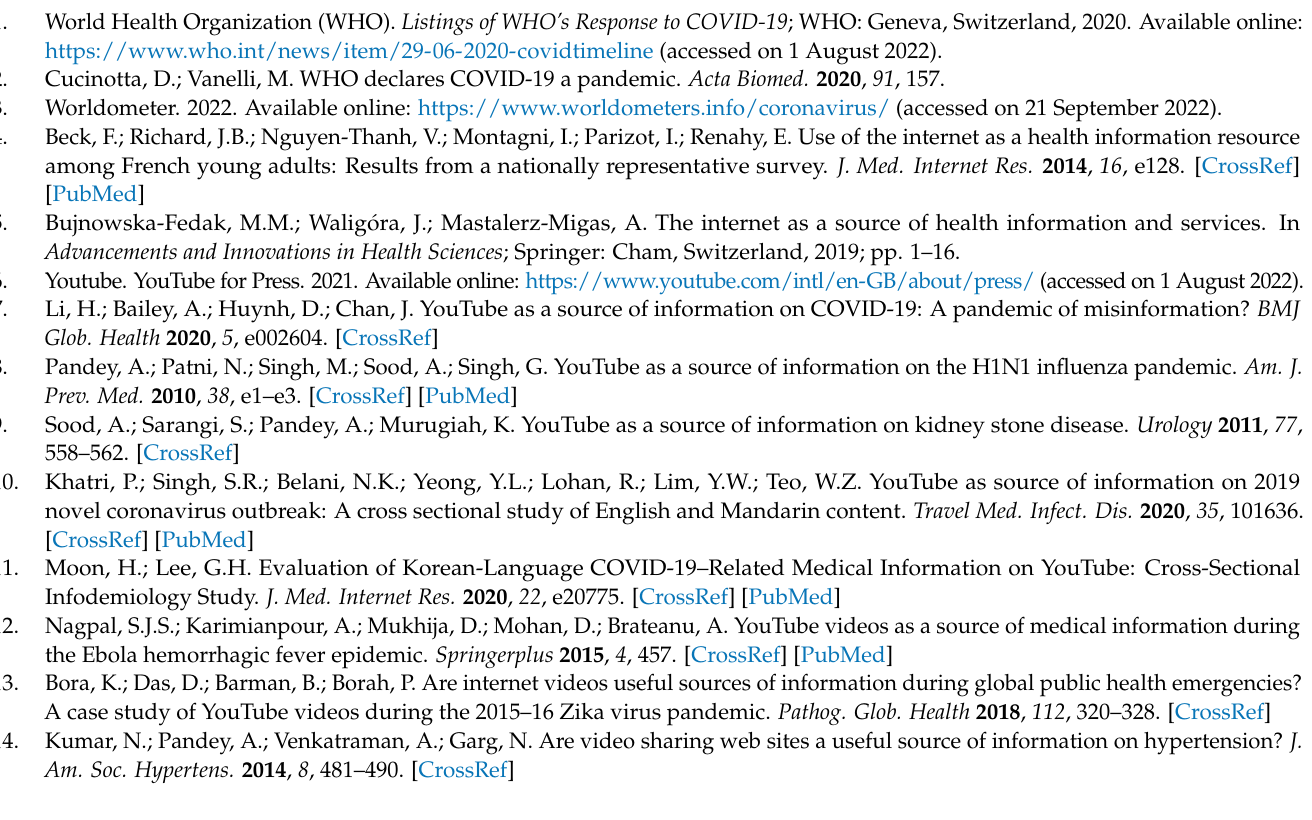
Table S2: Modified DISCERN Score, Table S3: Journal of the American Medical Association Score (JAMAS), Table S4: Audio-Visual Quality, Table S5: Accuracy Score, Table S6: Comprehensiveness Score, Table S7: Title–content consistency index, Table S8: Global Quality Score for educational value, Table S9: Examples of misleading nutrition information, Table S10: Determining the relationship level between